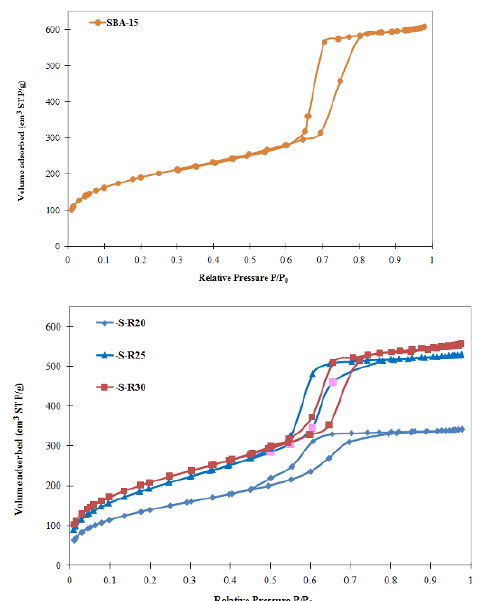
Figure 2. Nitrogen adsorption-desorption isotherms plot at 77 K of: (a)pureSBA-15and(b)materialspreparedbyin-situfunc- tionalization with thiol groups.